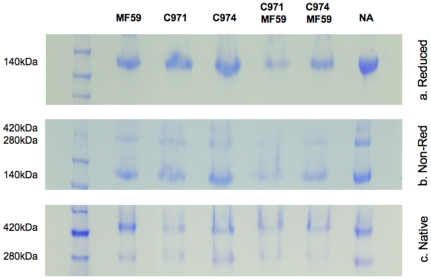
gp140SF162 conformation upon formulation with adjuvant.The gp140SF162 glycoprotein was formulated with or without adjuvants and assayed on PAGE gel for conformation. (a) Regardless of presence or absence of adjuvants, a single band at 140 kDa was observed in the reduced gel. (b) Similar observation was made in the non-reduced gel, where all the samples showed two bands at 140 kDa and 280 kDa, representing the non-crosslinked and disulfide crosslinked gp140 trimers, respectively. (c) A BN-PAGE gel was used to examine the native conformation of gp140 in the presence of adjuvants. None of the adjuvants appear to affect the structure of gp140.